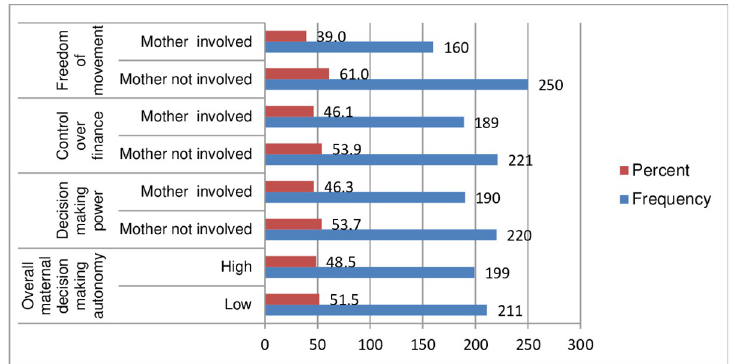
Fig 1. Maternal decision-making autonomy among postpartum mothers in Shashamate town, Oromia, Ethiopia, 2021 (N = 410).